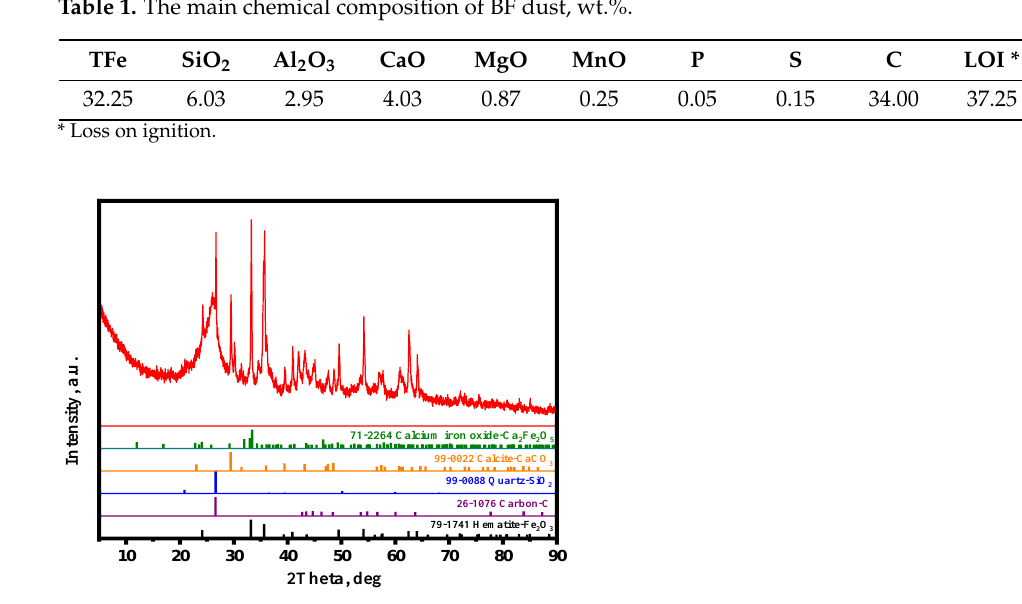
Figure 1. XRD pattern of BF dust.